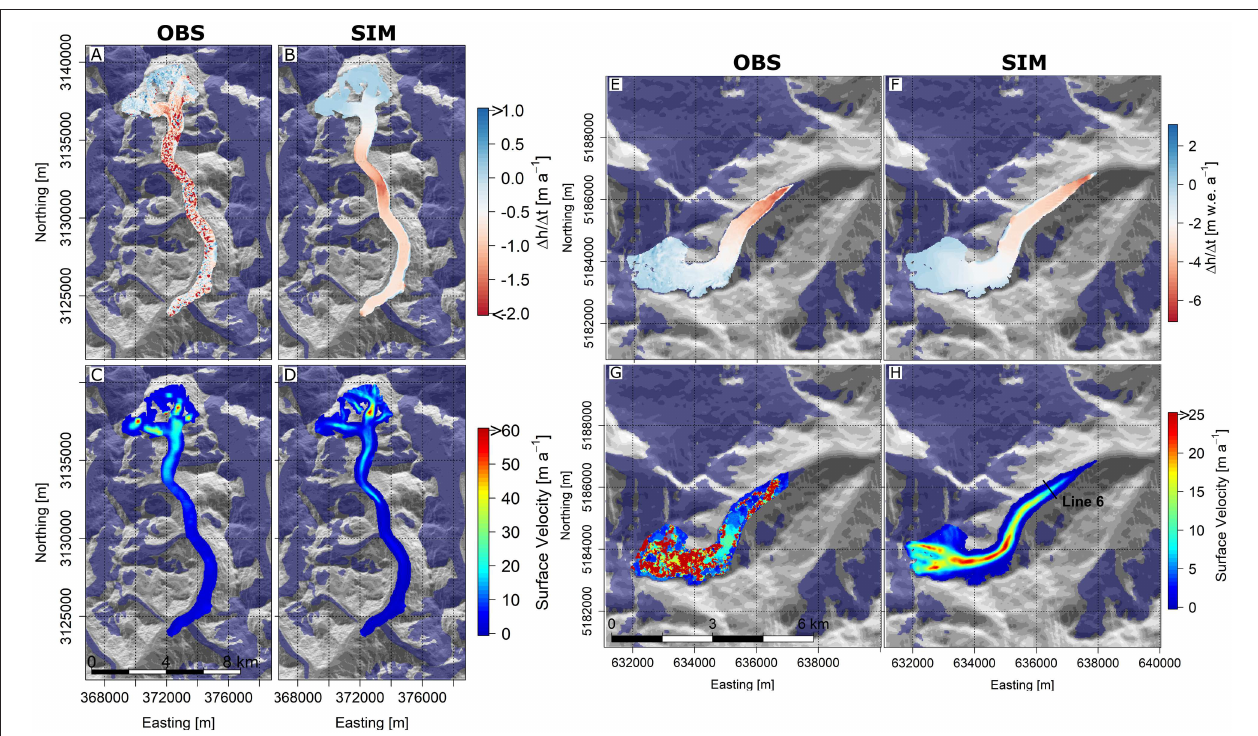
FIGURE 2 | Observed (OBS) and simulated (SIM) mean surface elevation change (A,B,E,F) and velocities (C,D,G,H) for the Langtang (A–D) and Hintereisferner (E–H) glaciers. Line 6 indicates the location of stone line 6 ( Span et al., 1997). Source of the observed mean surface elevation change grids are Ragettli et al. (2016) for the Langtang Glacier and Klug et al. (2018) for the Hintereisferner.